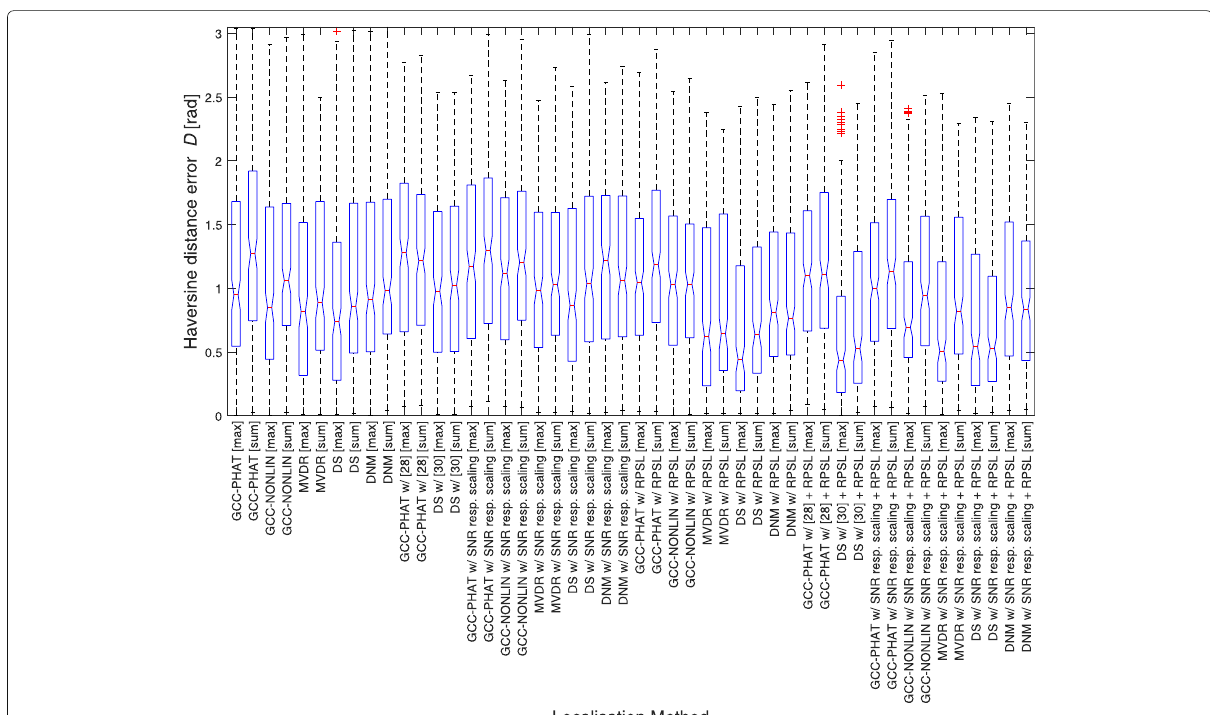
Fig. 14 Flying UAV—speech sound source (task 3) haversine distance error distribution. Red line indicates the median, upper and lower edges of the blue box indicate the 75% and 25% quartiles, upper and lower black bars indicate the maximum and minimum, and upper and lower corners of the trapezoidal indicate the 95% upper and lower confidence limits